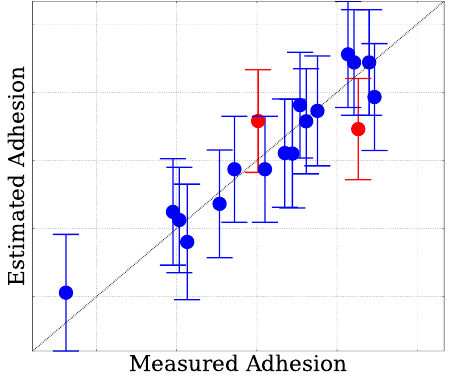
Figure 14: Measured and estimated adhesion